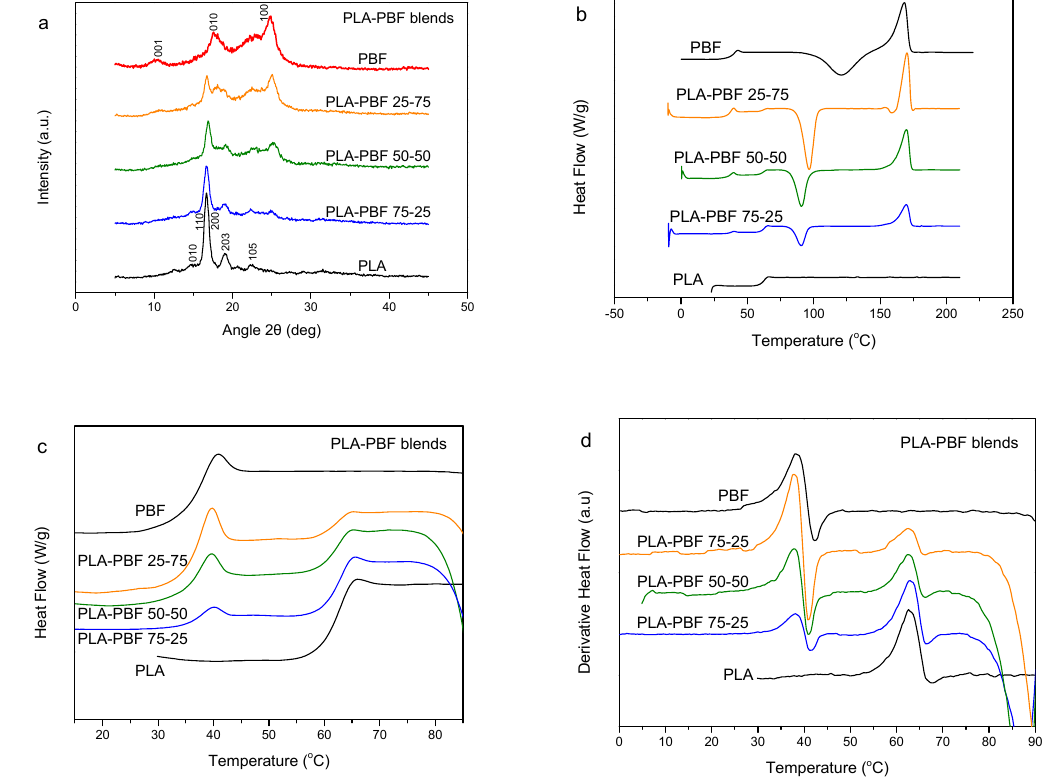
Figure 2. ( a ) Wide-angle X-ray diffraction (WAXD) patterns, ( b ) differential scanning calorimetry (DSC) traces of the melt-quenched samples upon heating, ( c ) details in the T g region, and ( d ) derivative heat flow thermograms for the poly(lactic acid) (PLA)–PBF blends.